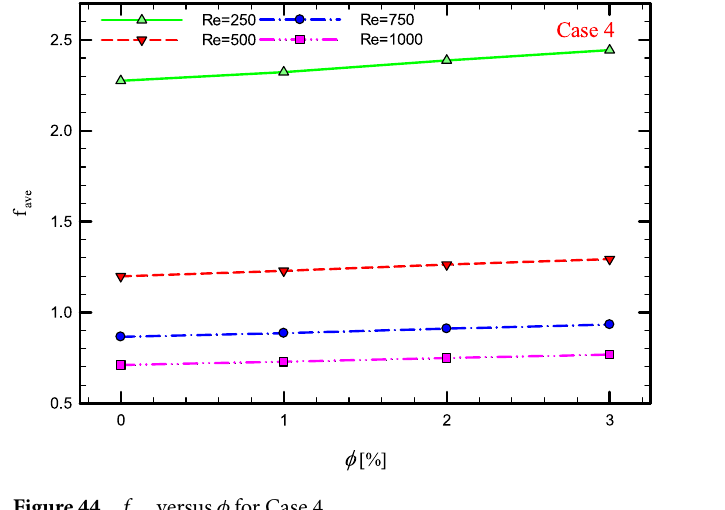
Figure 44. f ave versus φ for Case 4.